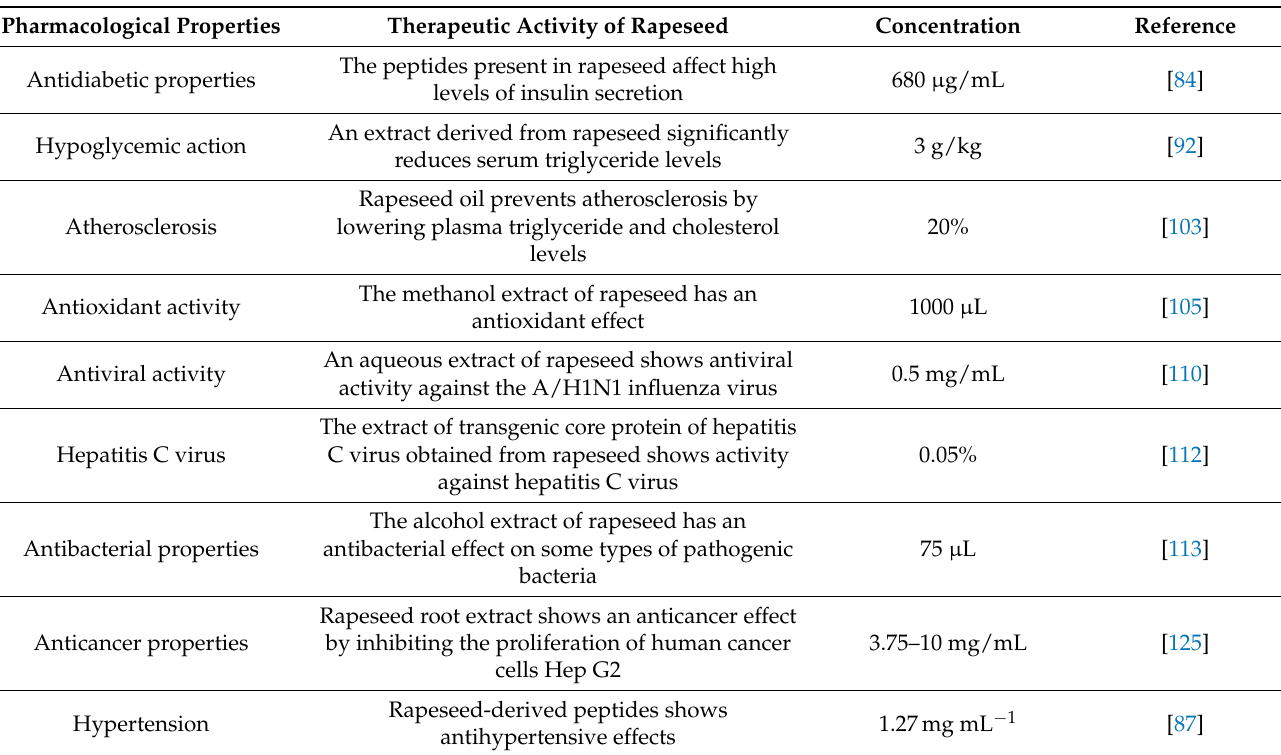
Table 3. Overview of pharmacological properties of rapeseed ( Brassica napus